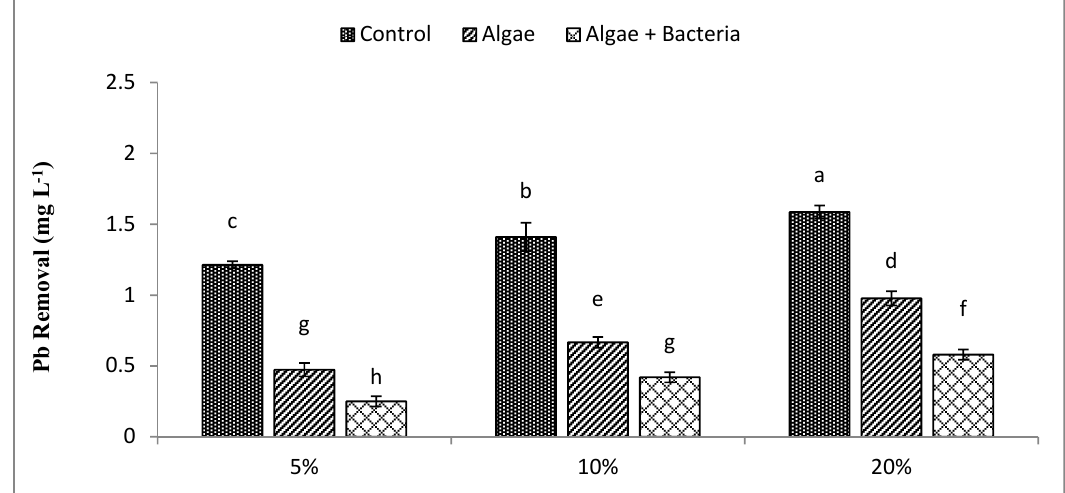
Figure 6. Efficiency of algae and algal–bacterial consortium for lead removal from textile industry wastewater at different dilution levels. Column shows mean values, and bars shows standard deviation (SD) of means. All means followed by different letters were significantly different according to Tukey HSD test at p < 0.05.